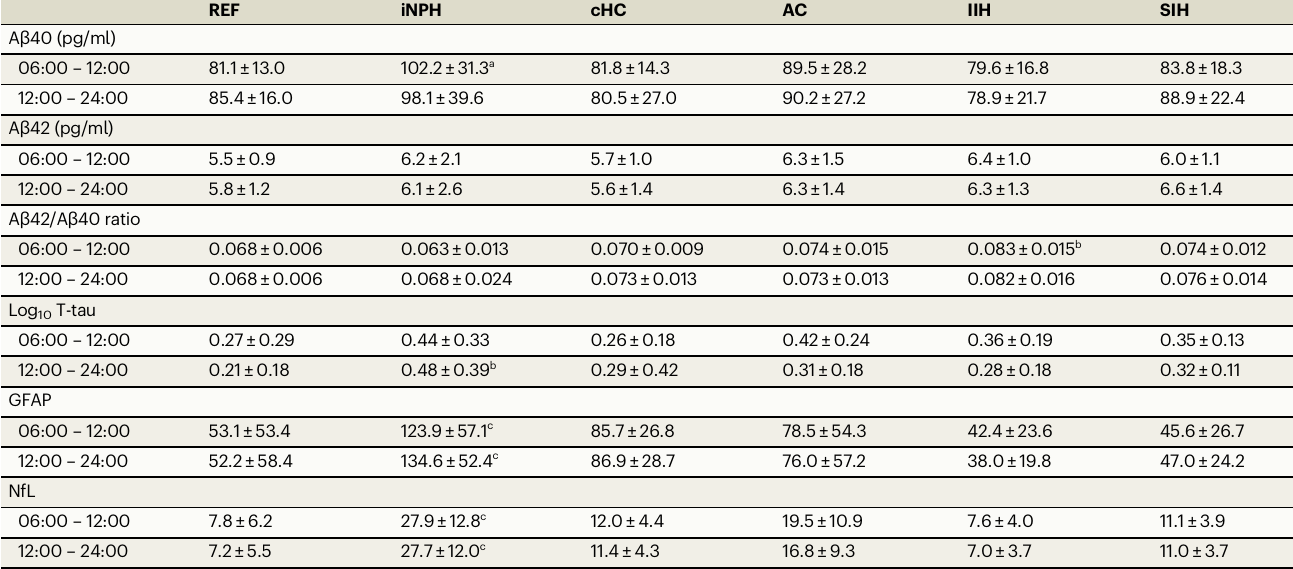
Table 3 | Plasma concentrations of neurodegeneration biomarkers in the different patient